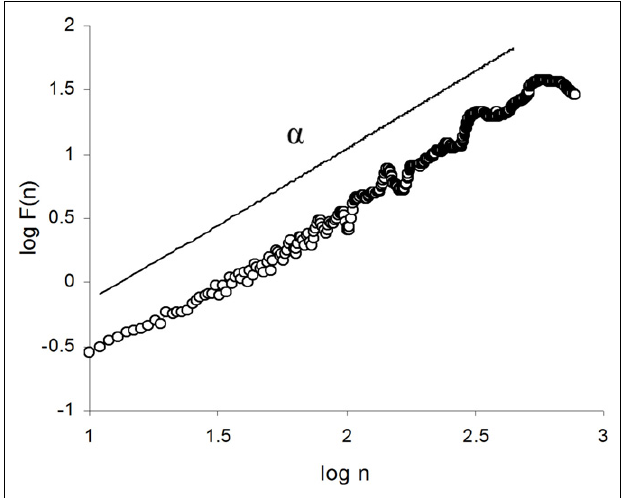
FIGURE 2 | Power Spectral Density analysis. The exponent β is given by the negative of the slope of the log–log representation of the power spectrum.